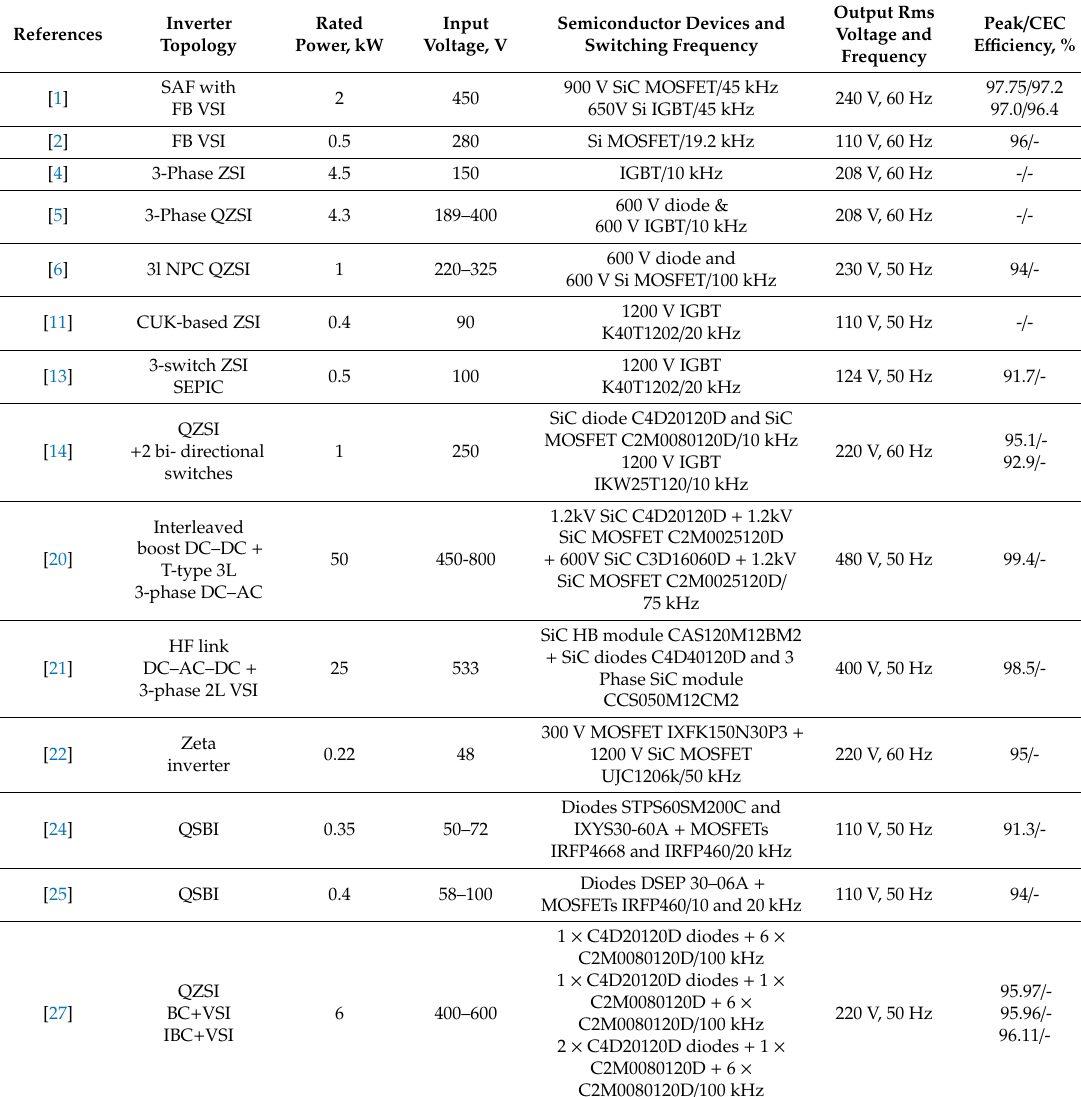
Table 1. Parameters and characteristics of existing